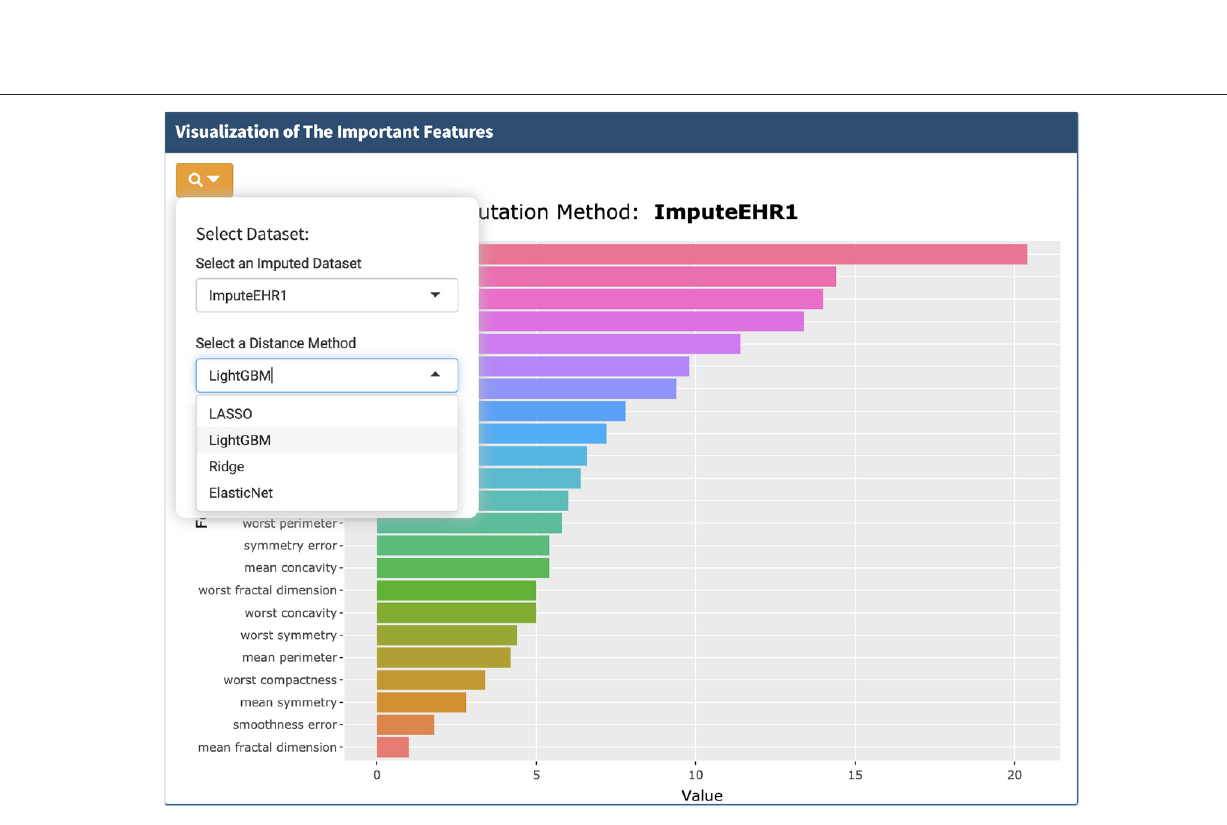
Frontiers in Genetics |